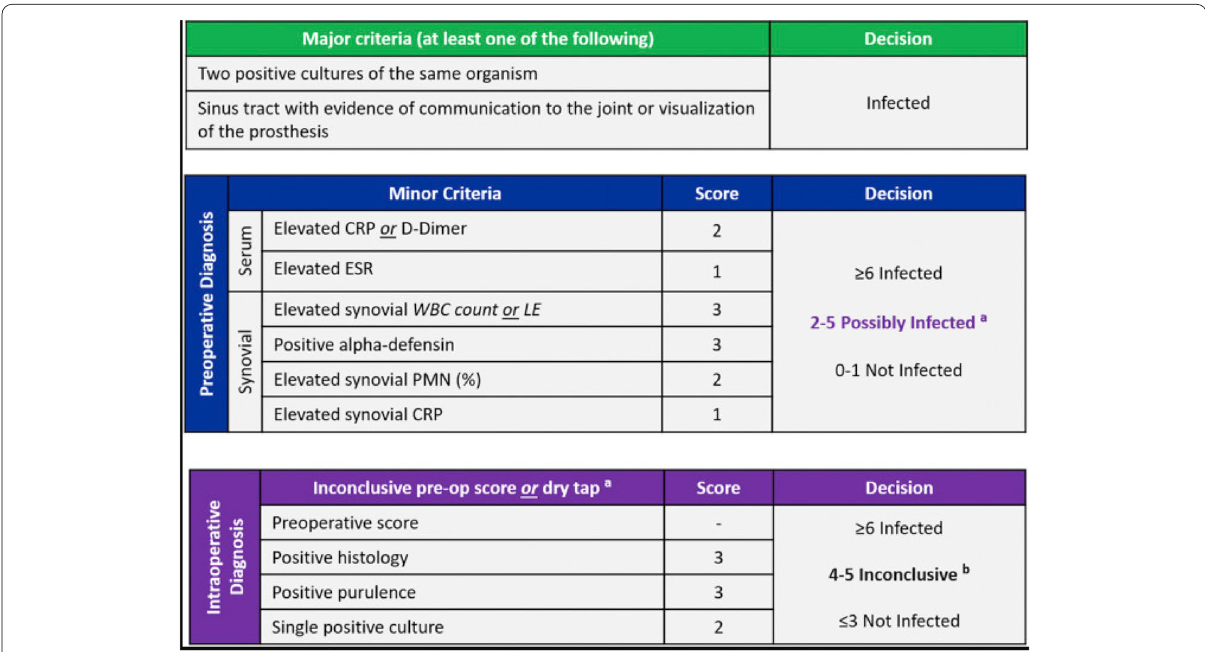
Fig. 2 New scoring system based on 2018 ICM Philadelphia (courtesy of Journal of Arthroplasty) definition for PJI. Caution is required in several conditions, like adverse local tissue reaction, crystal deposition disease, slow growing organisms, etc.